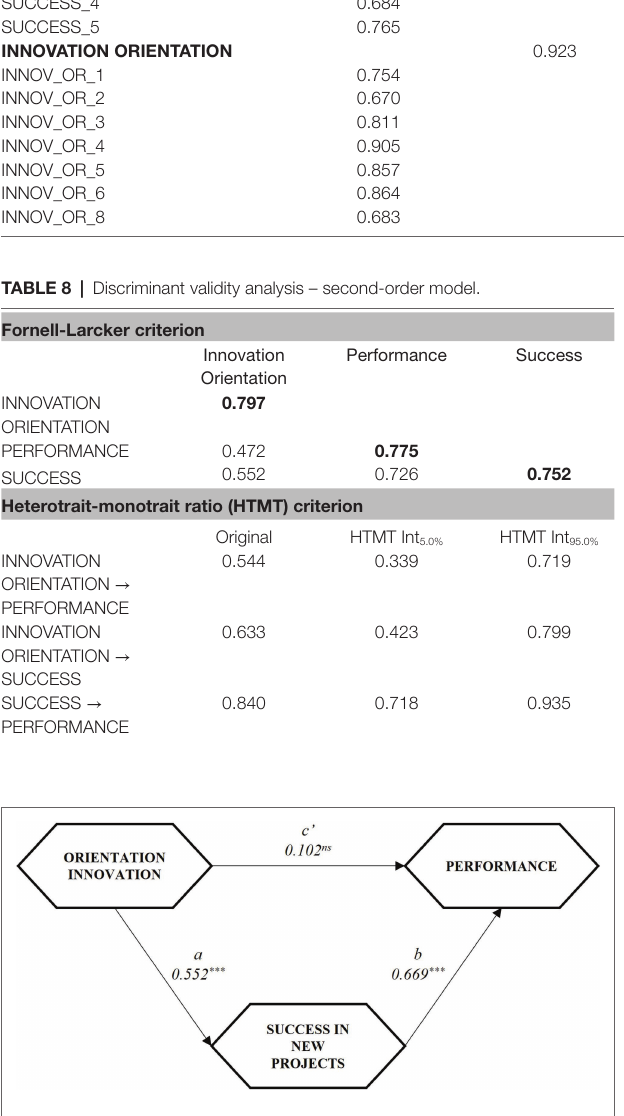
FIGURE 2 | Research model: indicators for the mediation